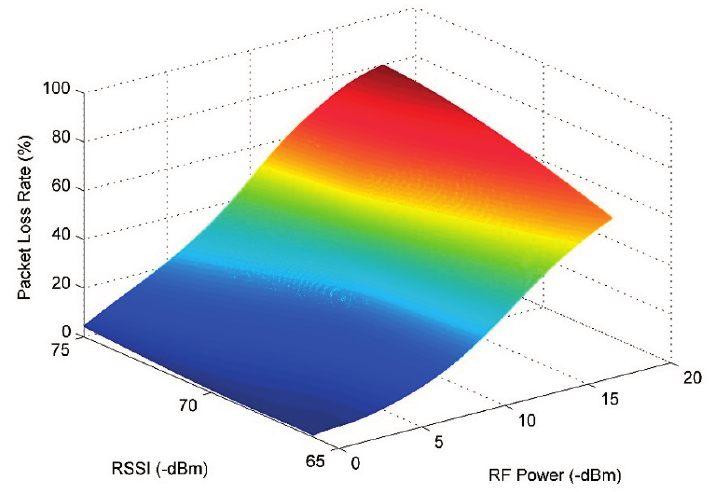
Figure 14. Packet Loss Rate variation with the RF Power difference and the RSSI variation.